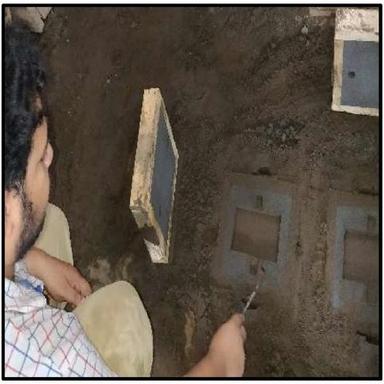
Mould preparation.